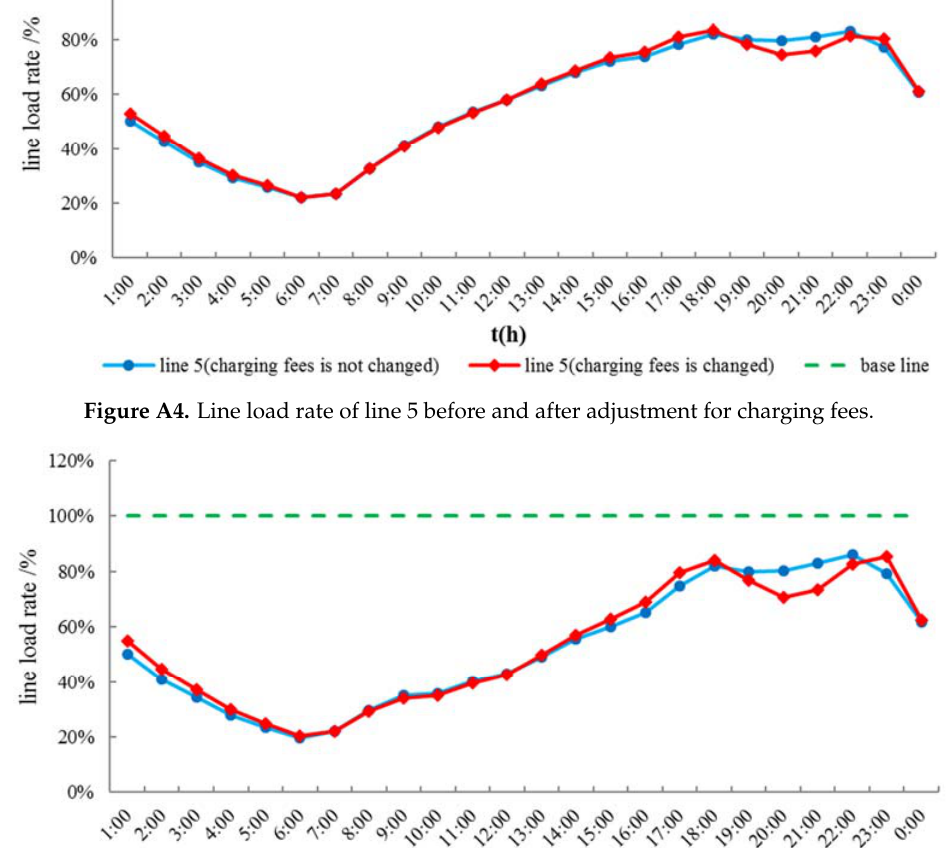
Figure A5. Line load rate of line 25 before and after adjustment for charging fees.